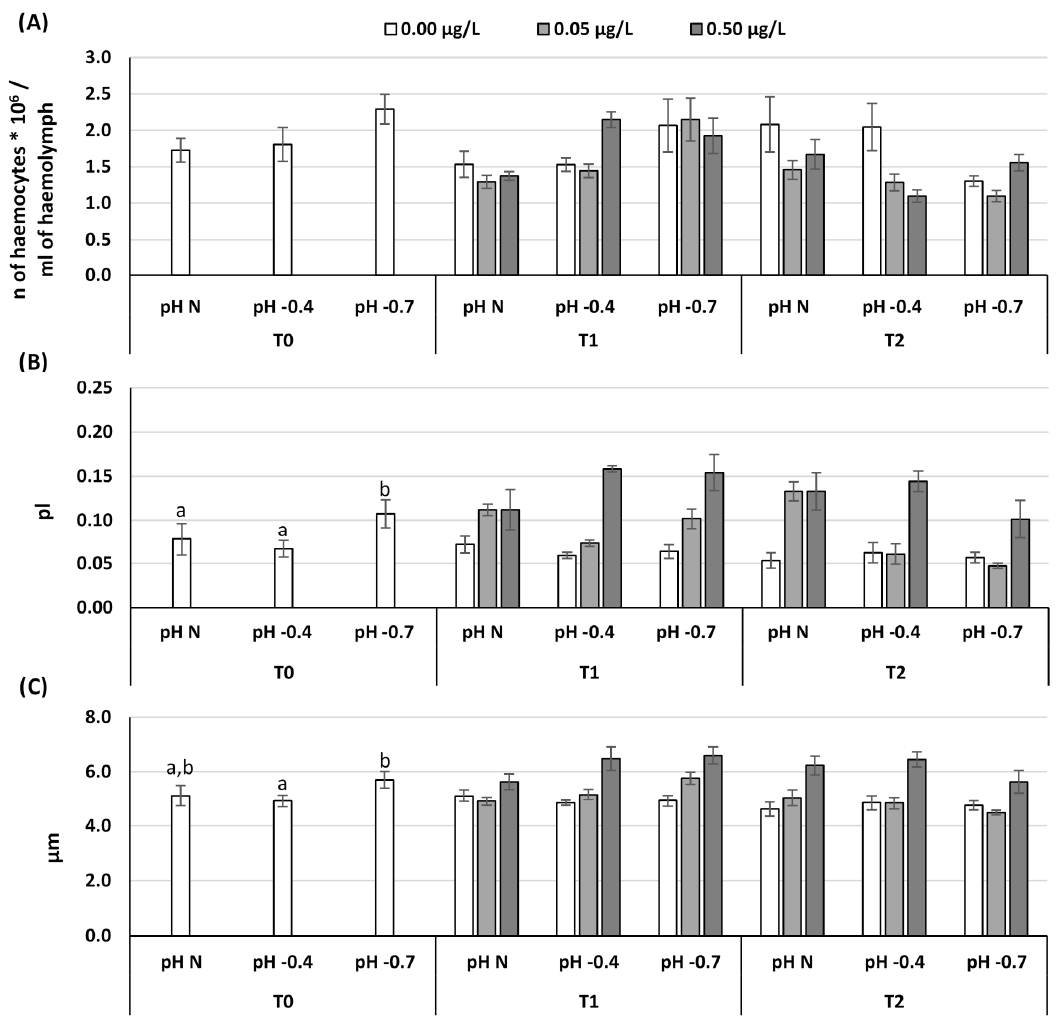
Figure 2. THC (number of hemocytes*10 6 /mL hemolymph) ( A ), hemocyte volume (pL) ( B ) and hemocyte diameter (µm) ( C ) in M. galloprovincialis . Values are the means ± SE (n = 6). Columns are white for 0.00 µg/L caffeine concentration, light grey for 0.05 µg/L caffeine concentration and dark grey for 0.50 µg/L caffeine concentration. At T0, differences among pH N, pH -0.4 and pH -0.7 are presented with lower-case letters (a–c).